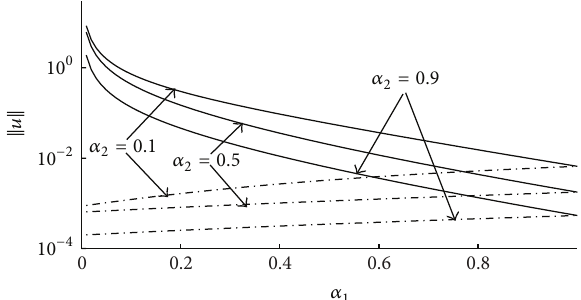
Figure 8: The dependencies for minimal control time from 𝛼 at 𝑝 󸀠 = 1 and different values of parameter 𝑎 .